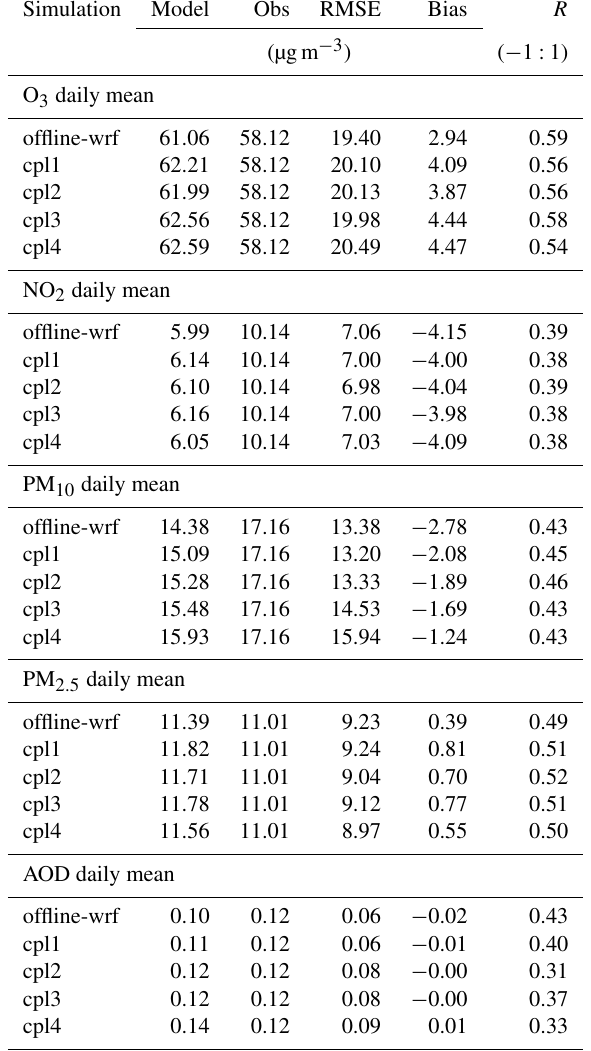
Table 5. Main results for the different coupling options of the v2020r1 CHIMERE version. Scores are calculated by comparison between surface observations for several stations in Europe and the corresponding model daily mean value. Statistical scores are pre- sented for O 3 , NO 2 , PM 10 , PM 2 . 5 , and